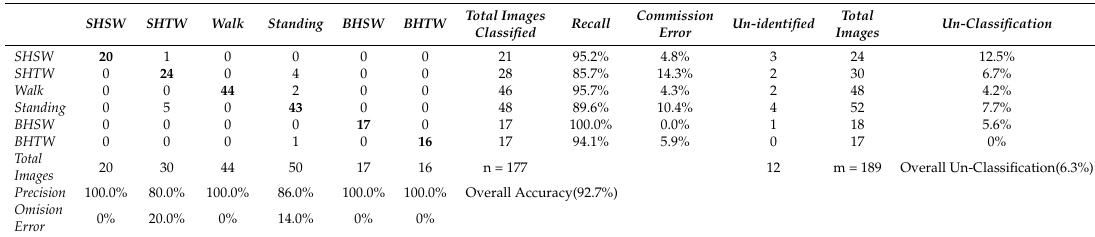
Table 8. Classification matrix for Lyova images.